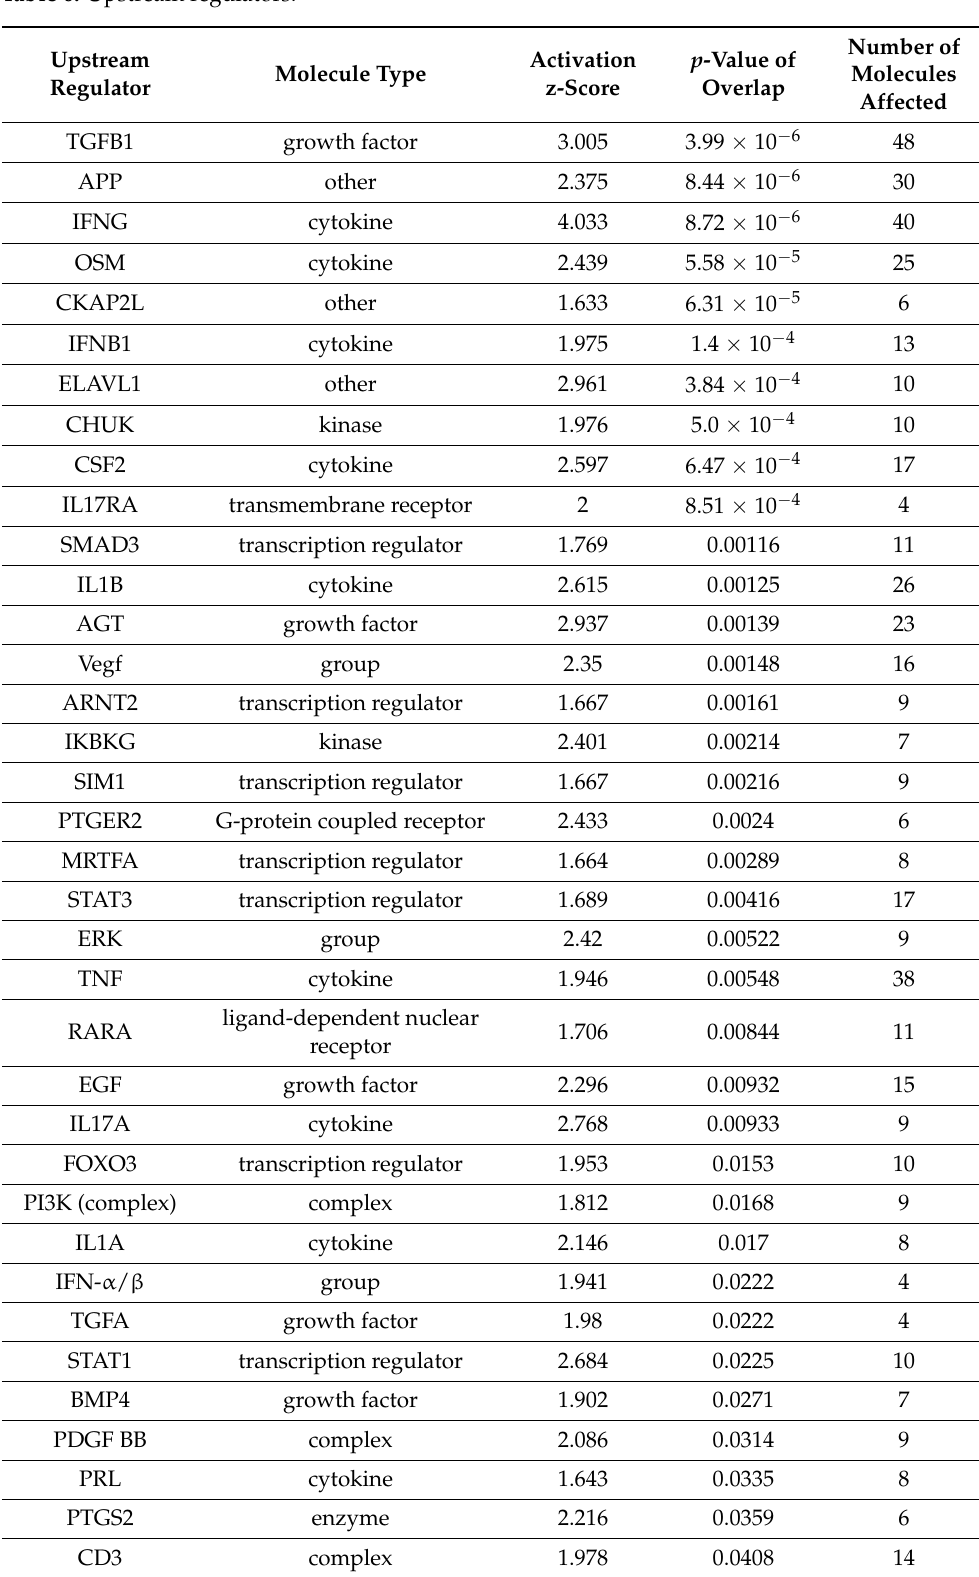
Table 6. Upstream